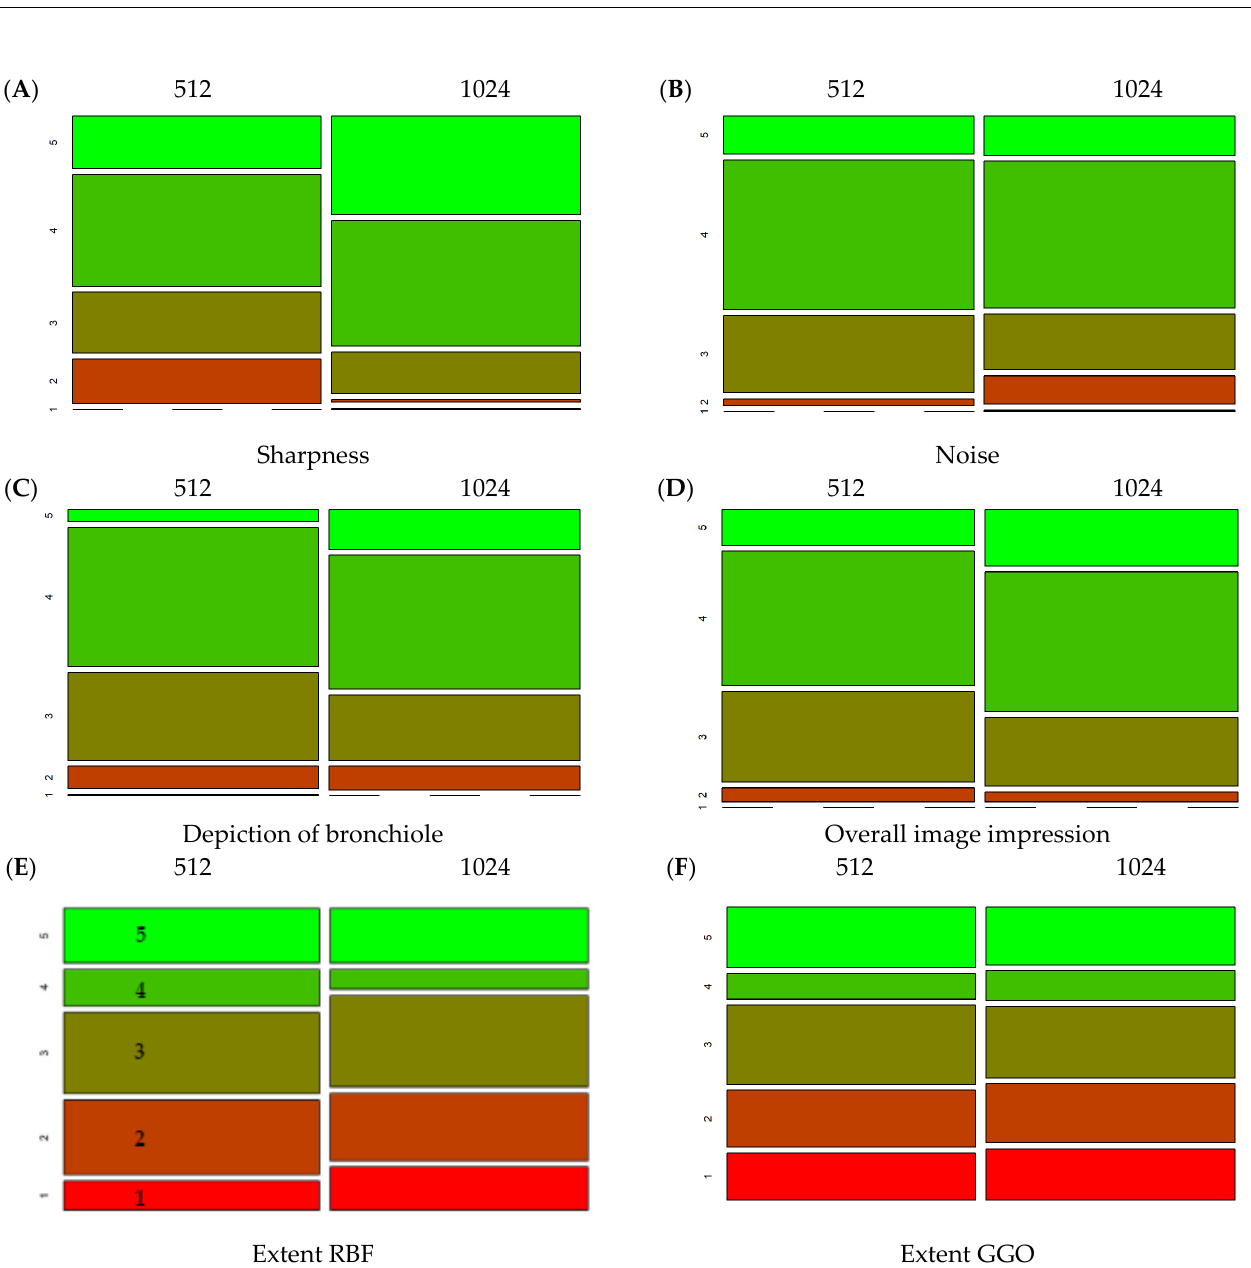
Figure 3. Mosaic plots with the score distribution (5-point Likert scale) of each subcategory; RBF = reticulations/bronchiectasis/fibrosis, GGO = ground-glass opacities. ( A ) shows the score distribution (1–5) for the two different matrices of the subcategory sharpness, ( B ) of the subcategory noise, ( C ) of the subcategory depiction of bronchiole, ( D ) of the subcategory overall image impression, ( E ) of the subcategory extent of reticulations/bronchiectasis/fibrosis and ( F ) of the subcategory extent of ground-glass